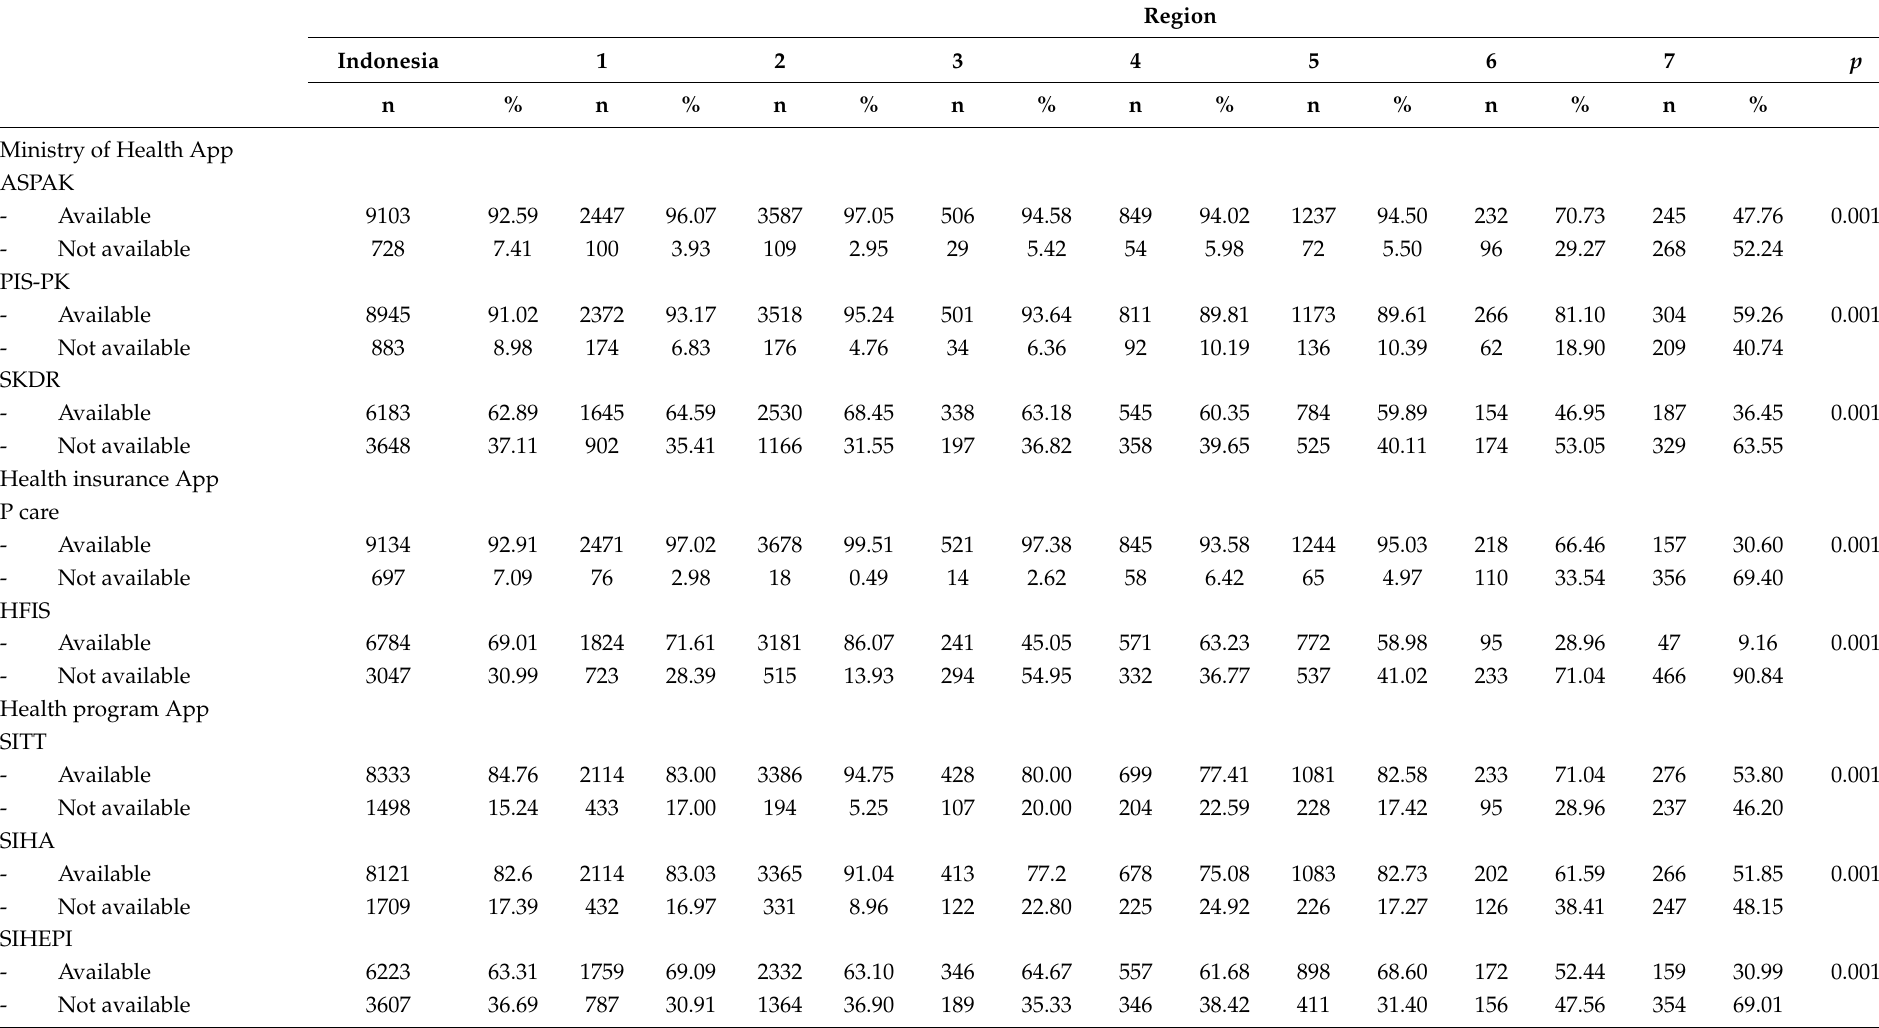
Table 3. Numbers and percentages of the presence of information programs based on the number of CHCs in each region in